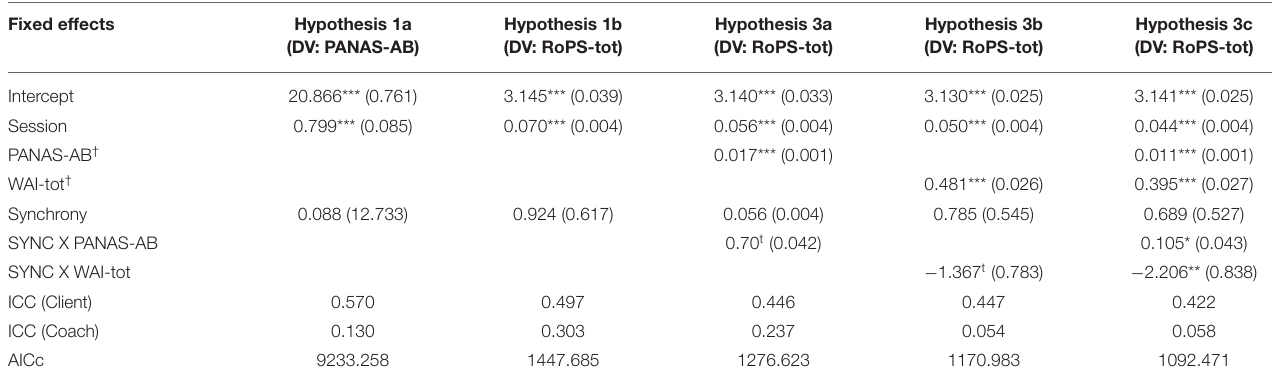
TABLE 4 | Parameter estimates (and Standard Errors) for mixed effects models examining Hypotheses 1 and